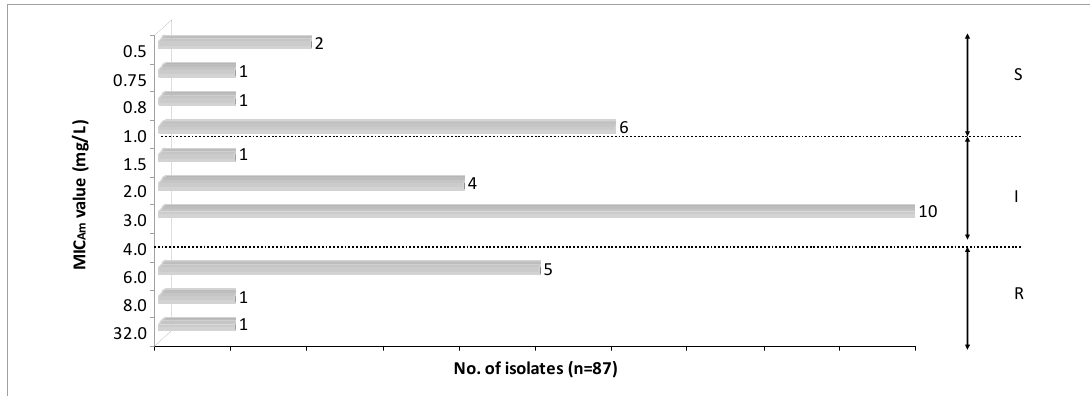
Figure 2. MIC Am values for ampicillin among Haemophilus parainfluenzae isolates from respiratory microbiota. S—susceptible isolates, I—susceptible, increased exposure (formerly intermediate) isolates, R—resistant isolates.